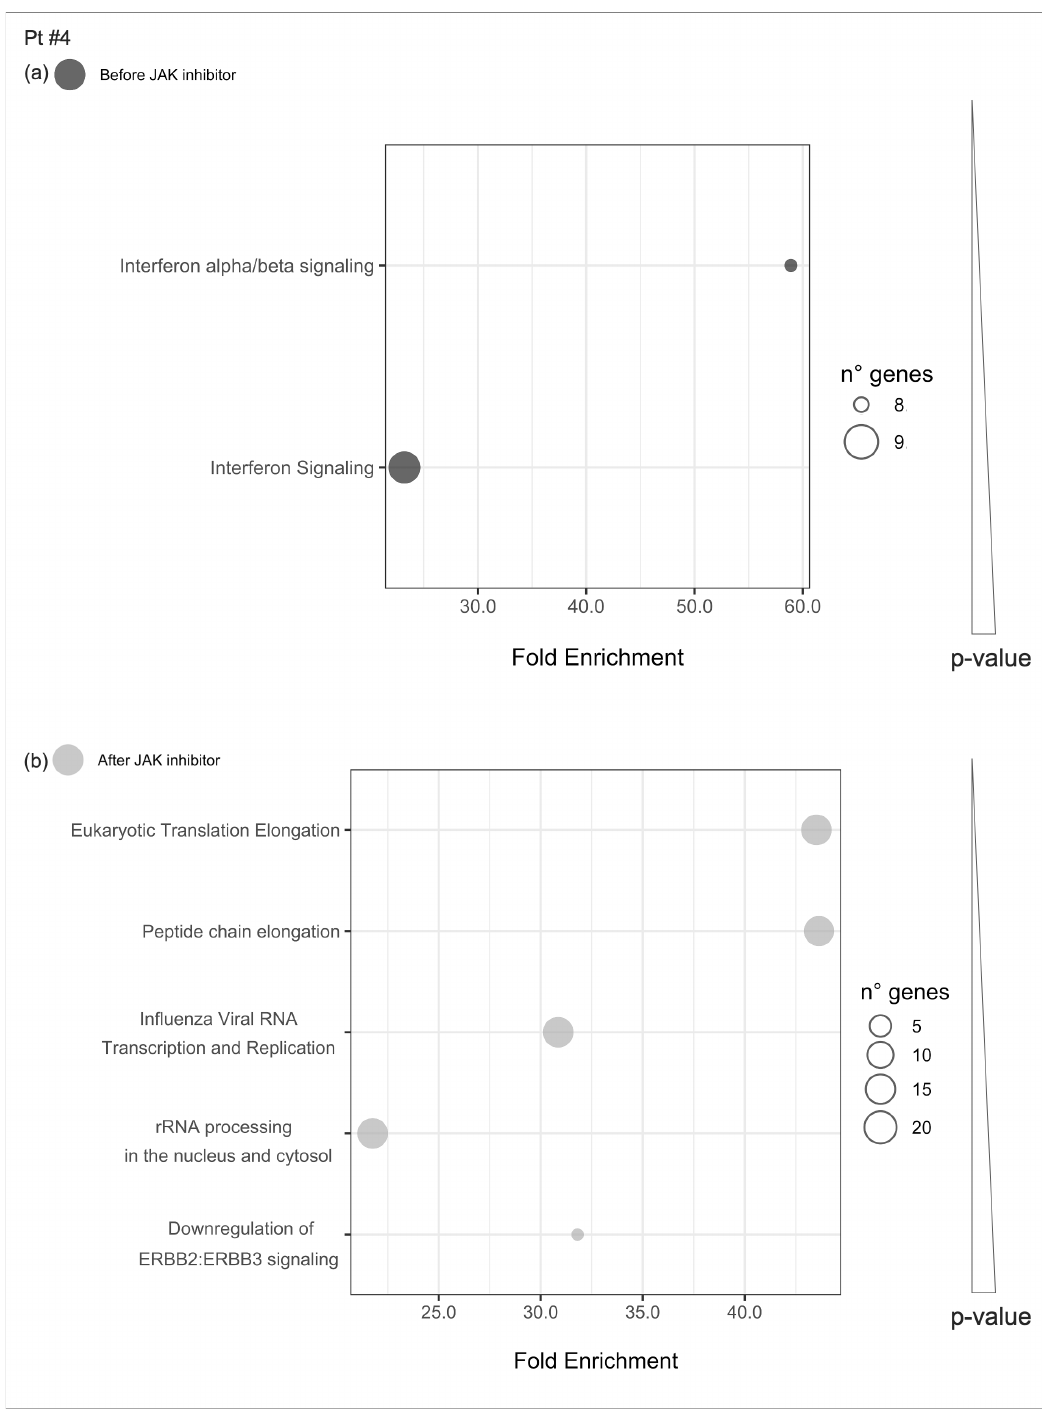
Figure 11. Pathway enrichment analysis was run on di ff erential expressed genes resulting from the comparison between patient #4 before JAKinhibs and the control-group subjects and between patient #4 after JAKinhibs and the controls. Pathways altered uniquely before ( a ) or uniquely after ( b ) JAKinhibs were chosen. Each dot represents a pathway, and the size is directly proportional to the number of genes. On the X -axis the pathway fold enrichment is displayed. All the selected pathways showed a lowest adjusted p -value of the given term over all iterations ≤ 0.01, and the five most enriched pathways were elected, where applicable. Pathways are ordered by increasing p -values. Pathways altered before JAKinhibs are colored in dark grey and those altered after JAKinhibs in light